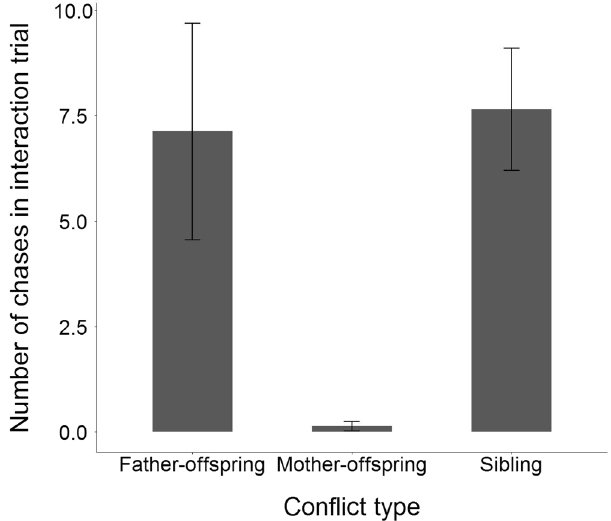
Figure 1. The level of aggressive behaviour, measured as chasing behaviour, between mothers and their offspring, fathers and their offspring and between siblings within Liopholis whitii families. Error bars represent one standard error of the